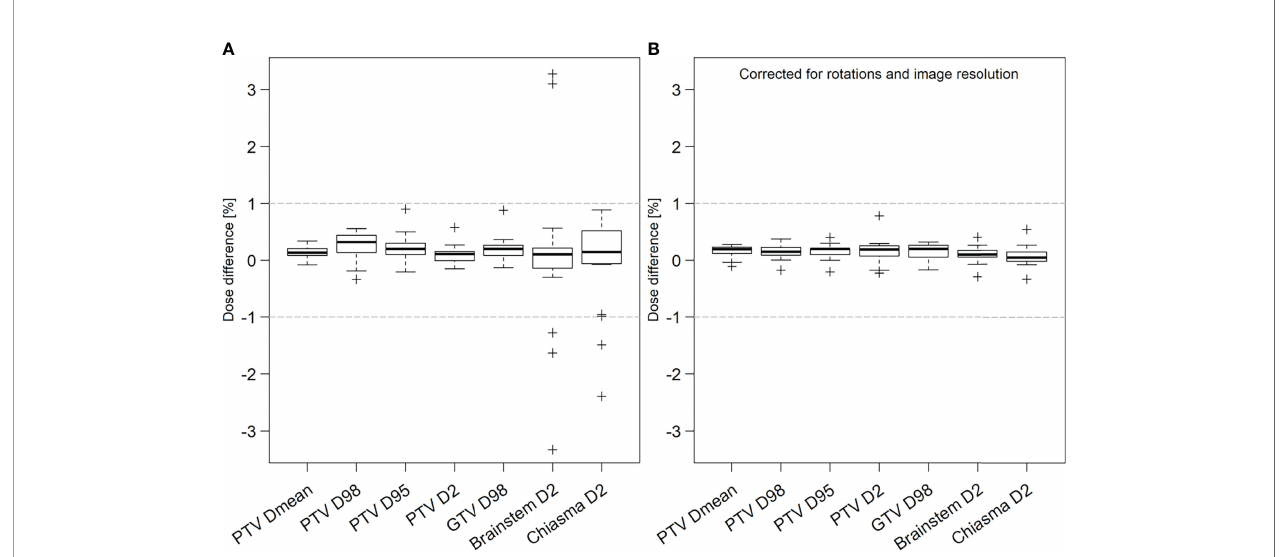
FIGURE 2 | Prospective (A) and retrospective (B) analysis of dose difference between treatment plans calculated on sCT and CT images for target (PTV and GTV) and organs at risk (OAR) brainstem and chiasma for all patients. In the prospective results, OAR outliers outside ±1% had relative dose levels more than 10% below the clinical tolerance for absorbed dose to OARs. In the additional retrospective analysis, original dose distribution has been corrected for image rotations and image resolution differences between the sCT and CT. The thick black line in each box represents the median value for all patients. The box includes the 25th-75th percentiles, the interquartile range (IQR). Whiskers represent the maximum and minimum values within 1.5 IQR and the crosses represent any values outside that range. The grey horizontal lines represent ±1% dose